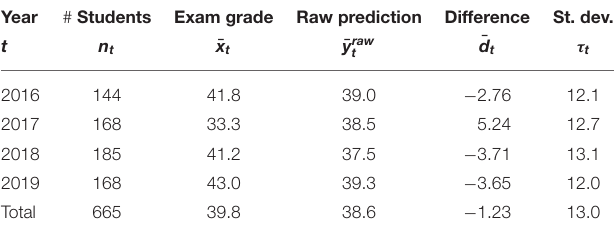
TABLE 1 | Descriptive statistics (means) of the data. Year # Students Exam grade Raw prediction Difference St.